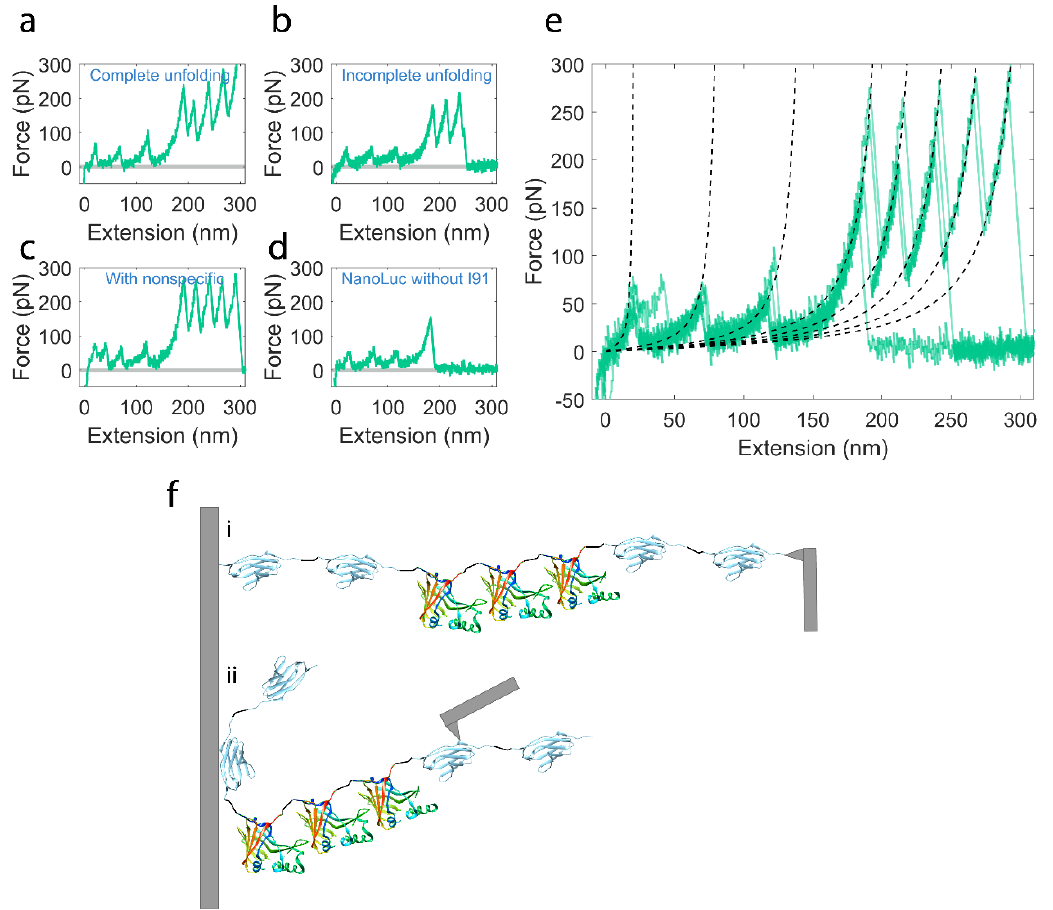
Figure 3. Results of unfolding experiments on I91 2 -NanoLuc 3 -I91 2 construct. ( a – d ) Four representative examples of force–extension curves. ( a ) Complete unfolding curve of I91 2 -NanoLuc 3 -I91 2 construct. ( b ) Unfolding curve with three NanoLuc events and only three I91 events which is incomplete. ( c ) Unfolding curve with nonspecific events at the beginning. ( d ) Unfolding curve with only unfolding events of NanoLuc. Please note that representative recordings in ( a – c ) categories were used in our analysis with n = 54. Additionally, even though the number of force peaks attributed to mechanical unfolding of I91, handle domains vary depending on the fragment picked up for stretching (as shown in Figure 3f), the number of small unfolding force peaks that we attribute to NanoLuc repeats is constant. ( e ) Overlay of 4 traces from ( a – d ). Dashed lines are worm-like chain (WLC) fits with persistence lengths p = 0.4 nm for NanoLuc domains and p = 0.3 for I91 domains. ( f ) Illustration of pulling experiment for full unfolding trace in 3a ( i ) and partial unfolding trace in 3d ( ii ). On the far left is the surface and on the far right is the cantilever.